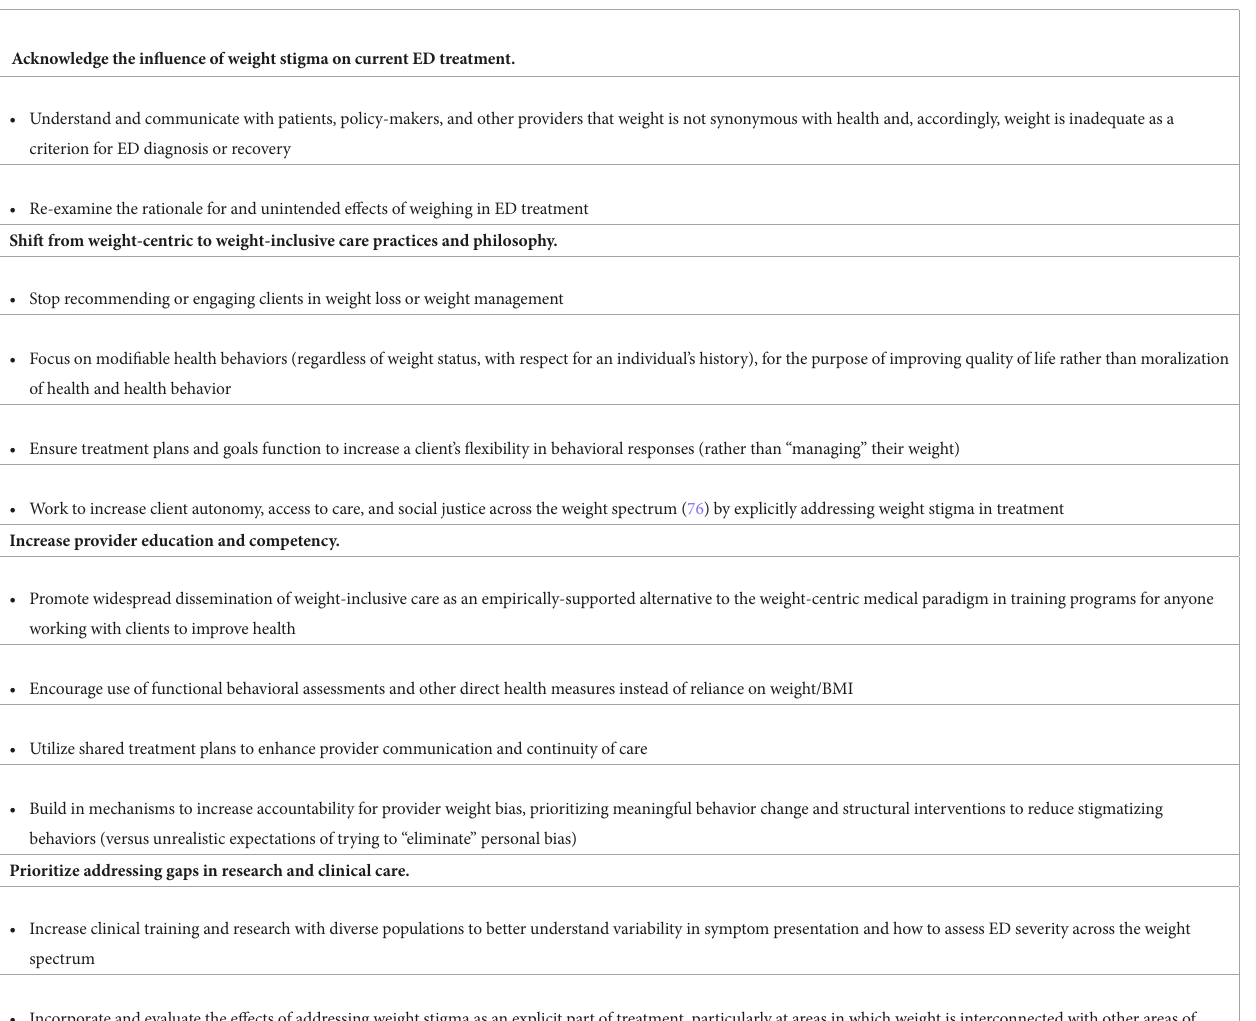
TABLE 1 Recommendations to foster a weight-inclusive paradigm in ED treatment and research.